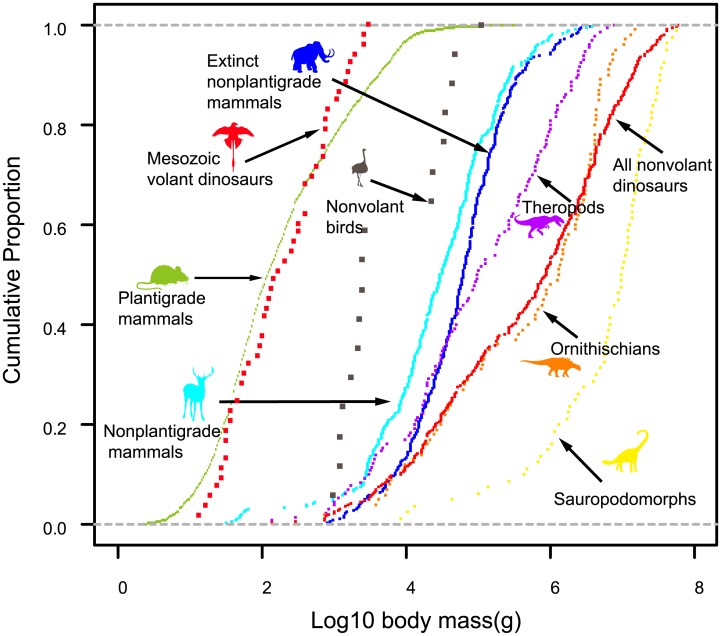
Cumulative curves of proportion of species number against log10 body mass for nonplantigrade taxa and plantigrade mammals.Each dot represents a species. Curves of plantigrade mammals and Mesozoic volant dinosaurs are shown on the far left and are distinct from curves for terrestrial nonplantigrade groups, indicating their considerably smaller body size. The curve for sauropodomorphs is on the far right, exhibiting a reverse L-shape that is distinct from other curves, indicating their large body size and lack of small species. Curves for extinct and extant nonplantigrade mammals are similar, although the curve for extinct species indicates a shift toward large body sizes. The difference between these two curves is likely due to taphonomic and sampling biases on the fossils of nonplantigrade mammals.